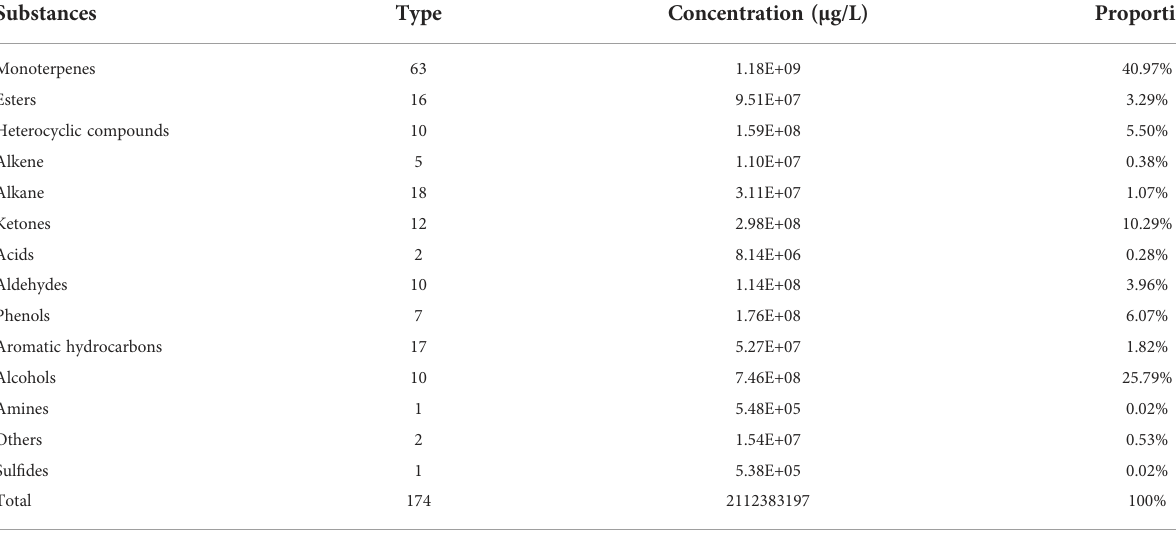
TABLE 1 Volatile organic metabolites detected in three Rosa rugosa cultivars with different fragrance